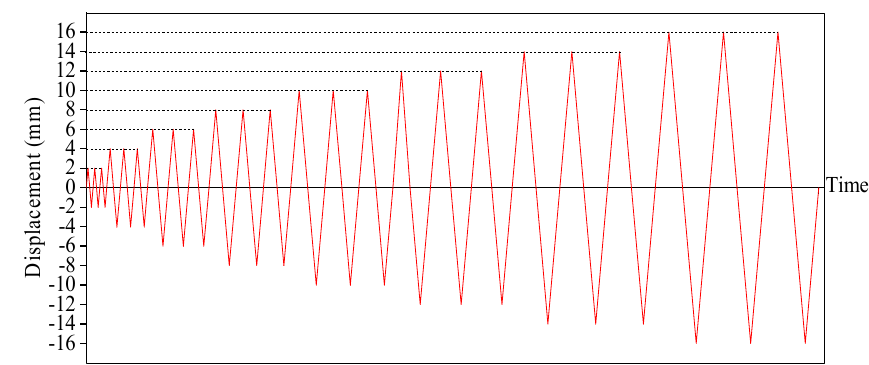
Figure 8. Loading scheme (unit: mm).